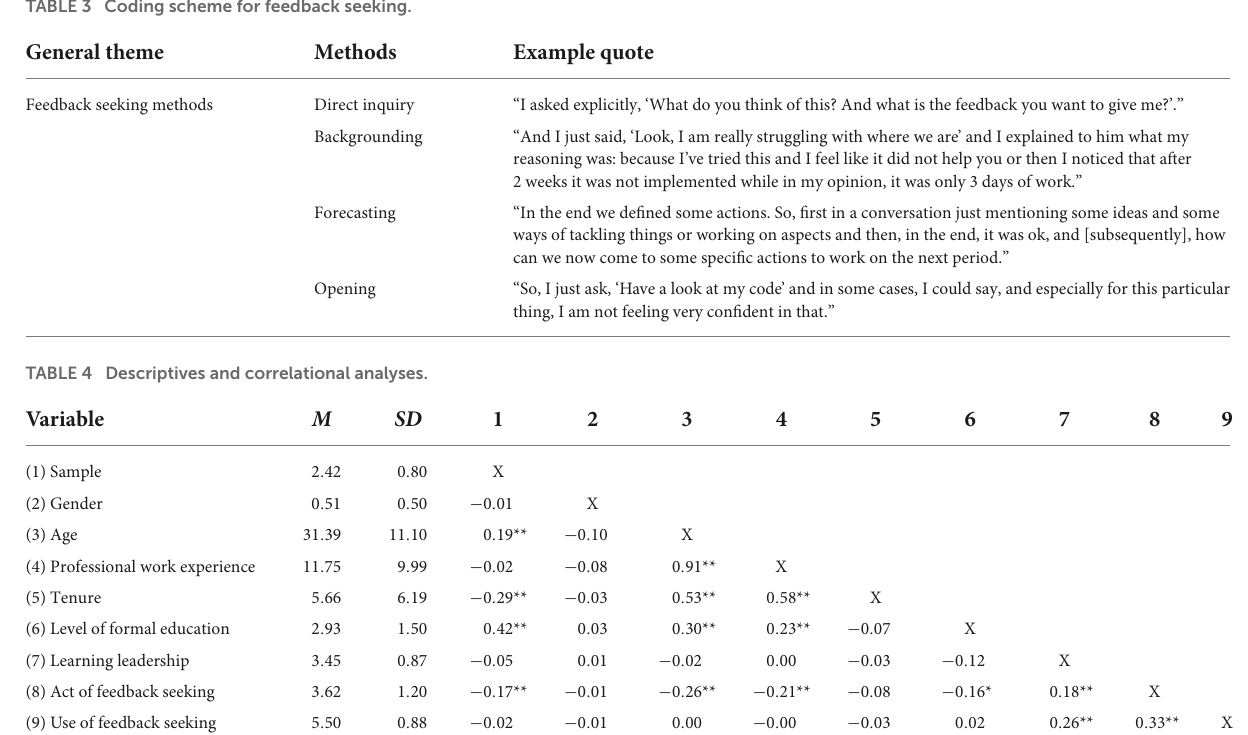
TABLE 3 Coding scheme for feedback seeking.